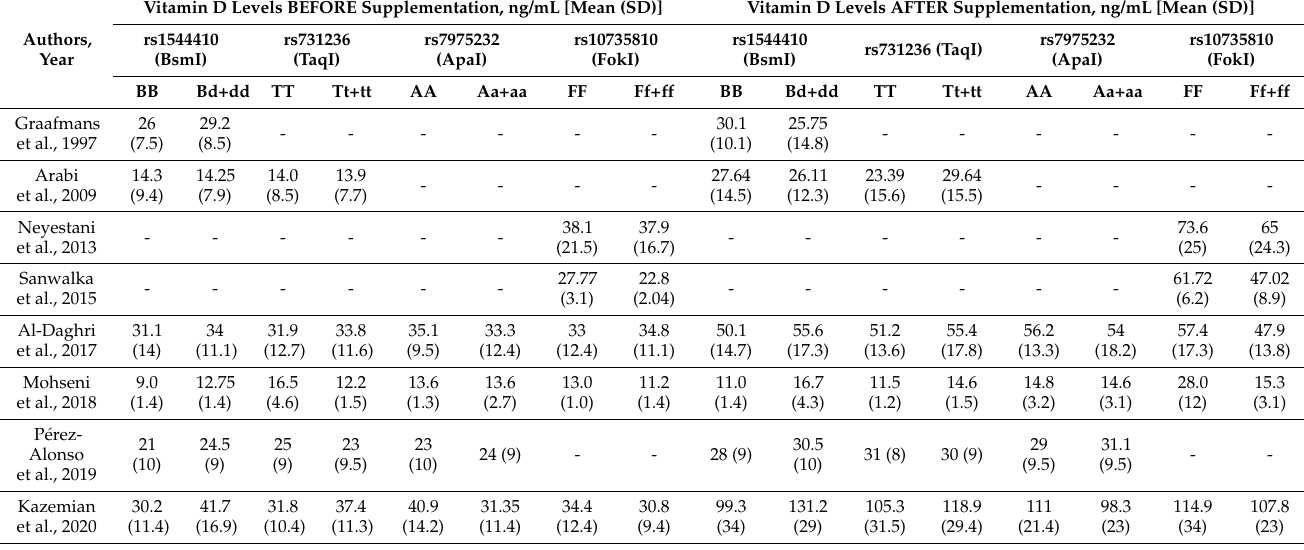
Table 2. Baseline and post-supplementation vitamin D levels according to the BsmI, TaqI, ApaI and FokI polymorphisms in the vitamin D receptor ( VDR ) gene.